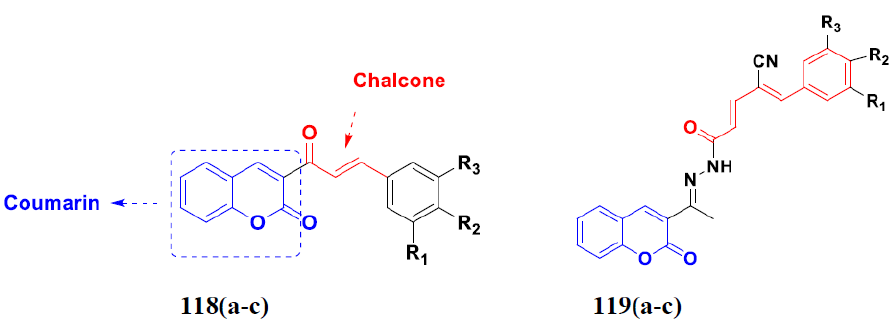
Figure 113. Structure of coumarin containing chalcone derivative [ 118 ( a – c ), 119 ( a – c )]. Table 100. In vitro cytotoxic activities of coumarin containing chalcone hybrid compounds [ 118 ( a – c ), 119 ( a – c )].